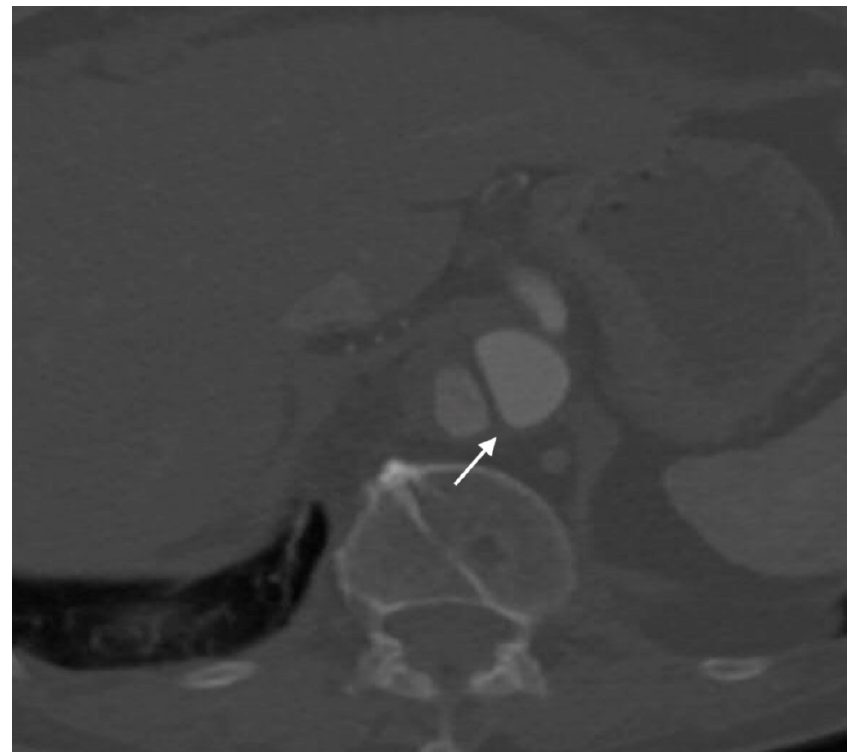
Figure 7. Axial image of aortic dissection demonstrating the beak sign (arrow). Note the acute angle between the dissection flap and the outer wall.